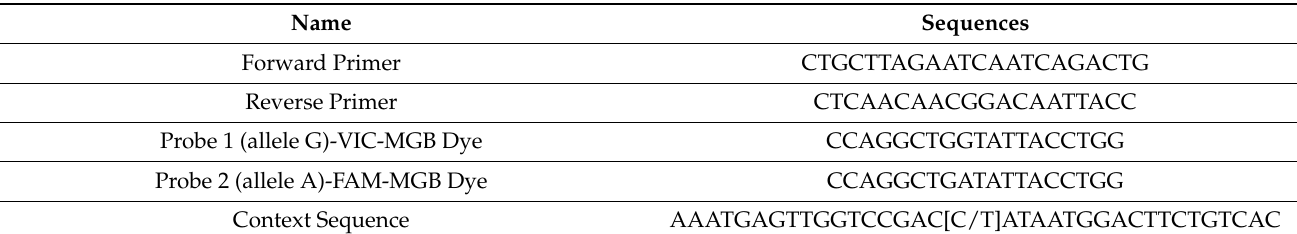
Table 1. Information necessary to order a Custom TaqMan ® SNP Genotyping Assay for the Galc gene in the Twi mouse